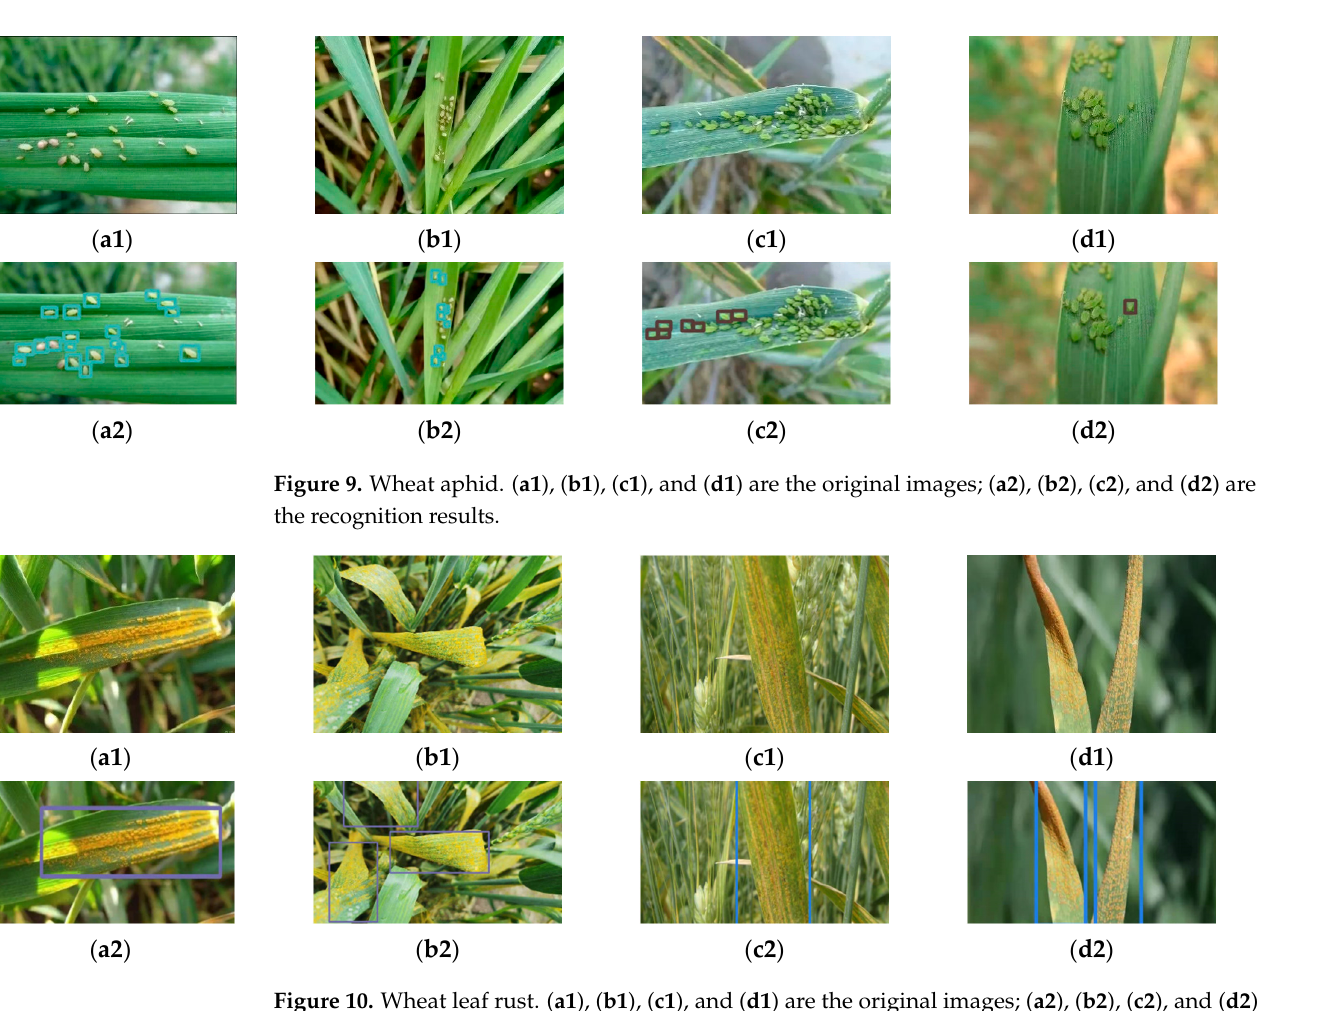
Figure 10. Wheat leaf rust. ( a1 ), ( b1 ), ( c1 ), and ( d1 ) are the original images; ( a2 ), ( b2 ), ( c2 ), and ( d2 ) are the recognition results.